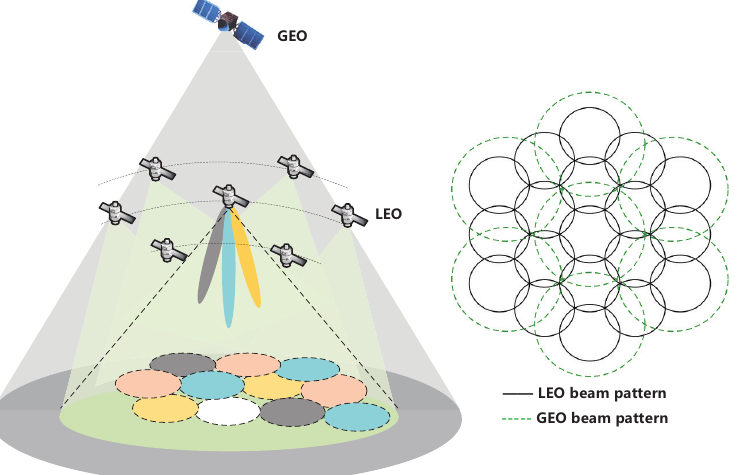
Figure 1. A typical coexistence scenario of the UD-LEO satellite system and a GEO satellite